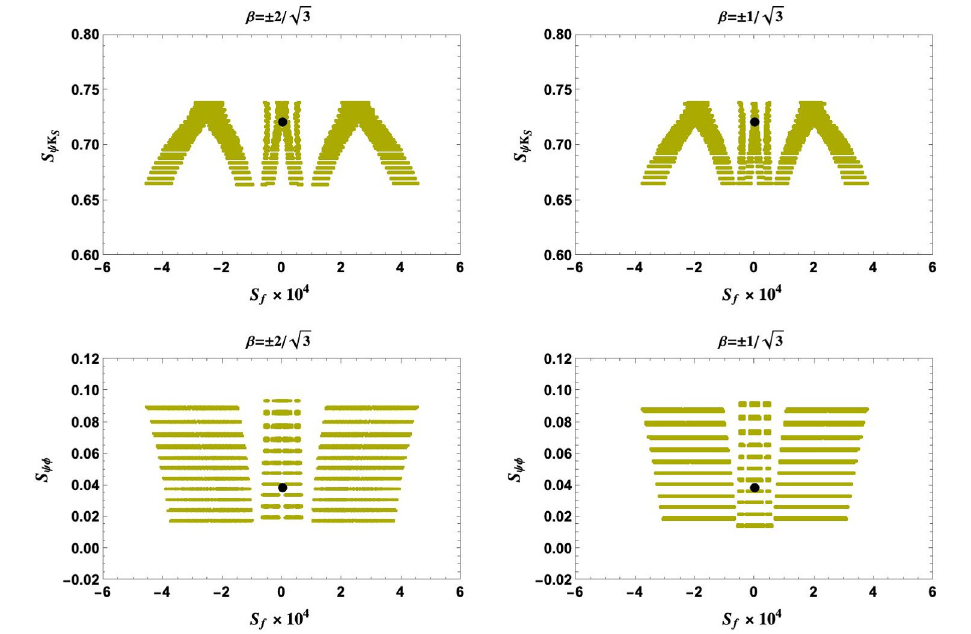
Figure 7 . Correlation in the 331 models between the S f asymmetry in (3.27) and the CP asym- metries S and S in the B and B systems. The 331 parameters are as in figure 2. The d s J/ψK S J/ψφ black dot is the SM